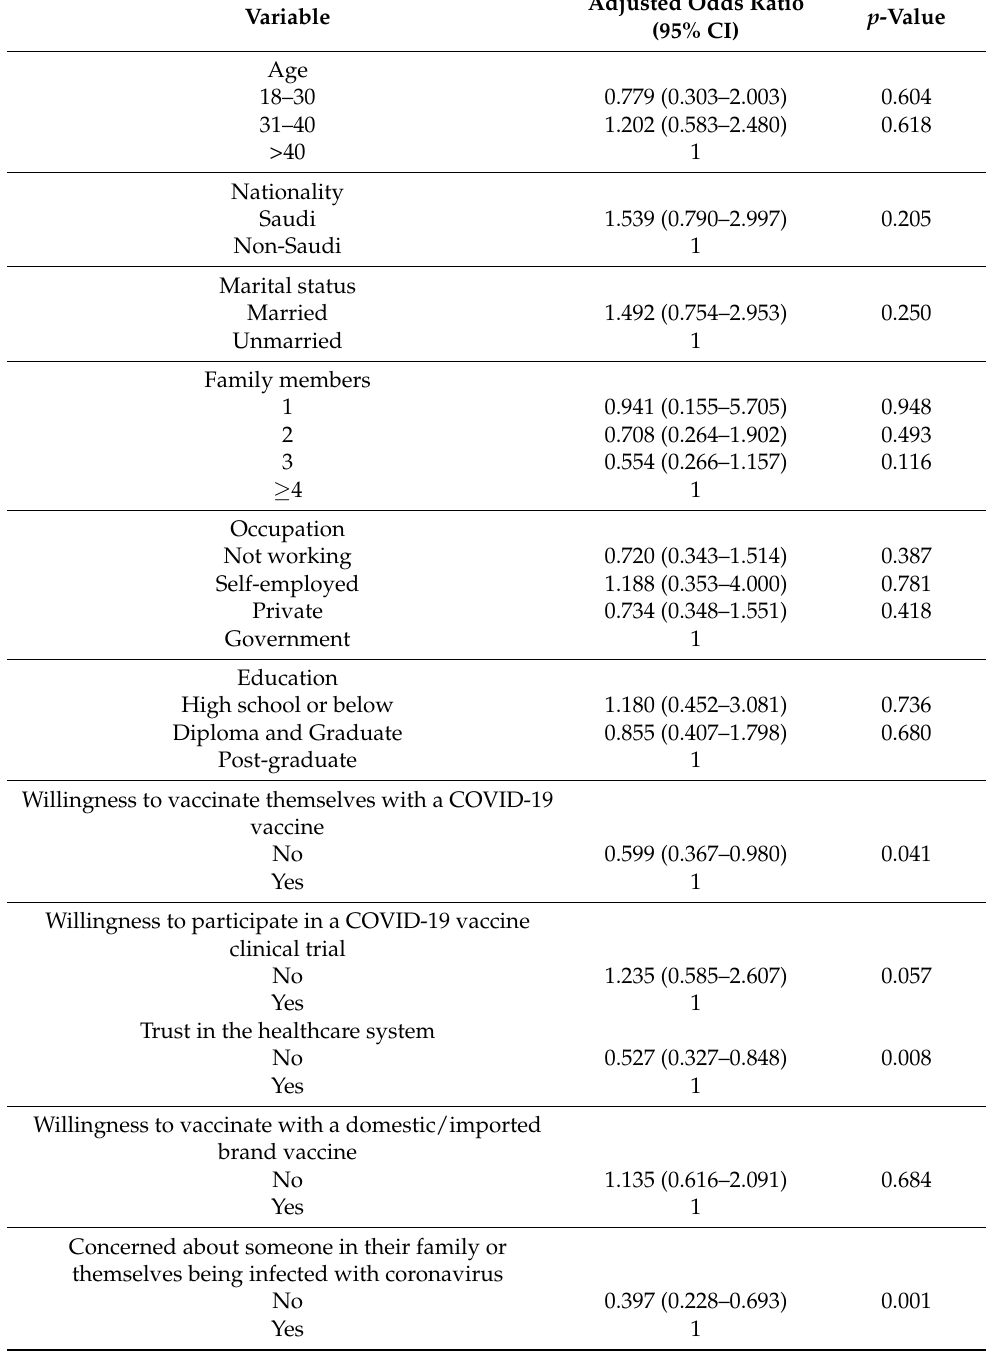
Table 4. Predictors related to the parents’ acceptance to vaccinate their children with a COVID-19